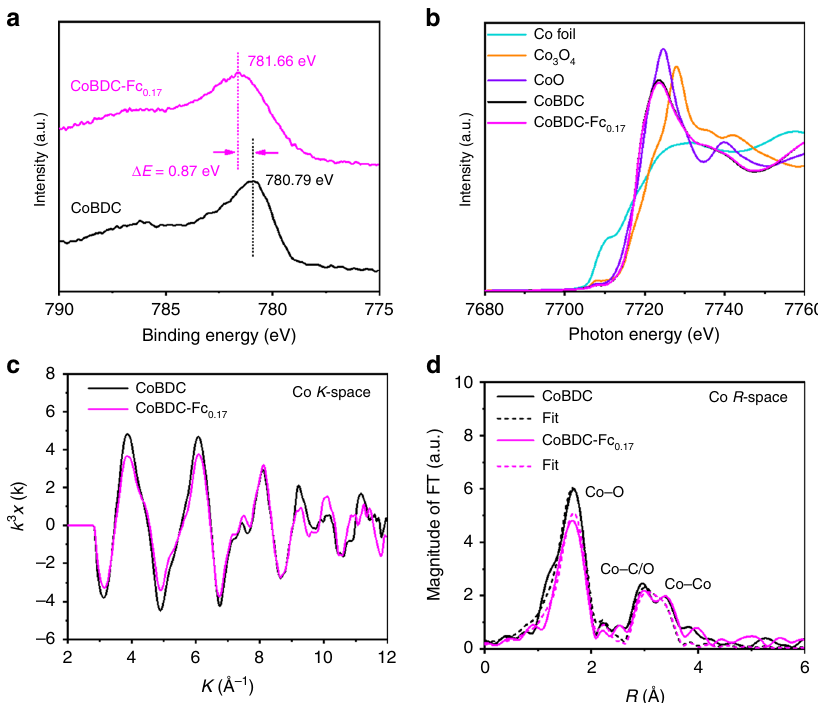
Fig. 4 Electronic structure characterization of CoBDC – Fc 0.17 . a Co 2 p 3/2 of CoBDC and CoBDC – Fc 0.17 . b Co K-edge XANES data of CoBDC, CoBDC – Fc 0.17 , and reference samples. c Co K-edge EXAFS of oscillations. d Fourier transformed EXAFS spectra of CoBDC and CoBDC – Fc 0.17